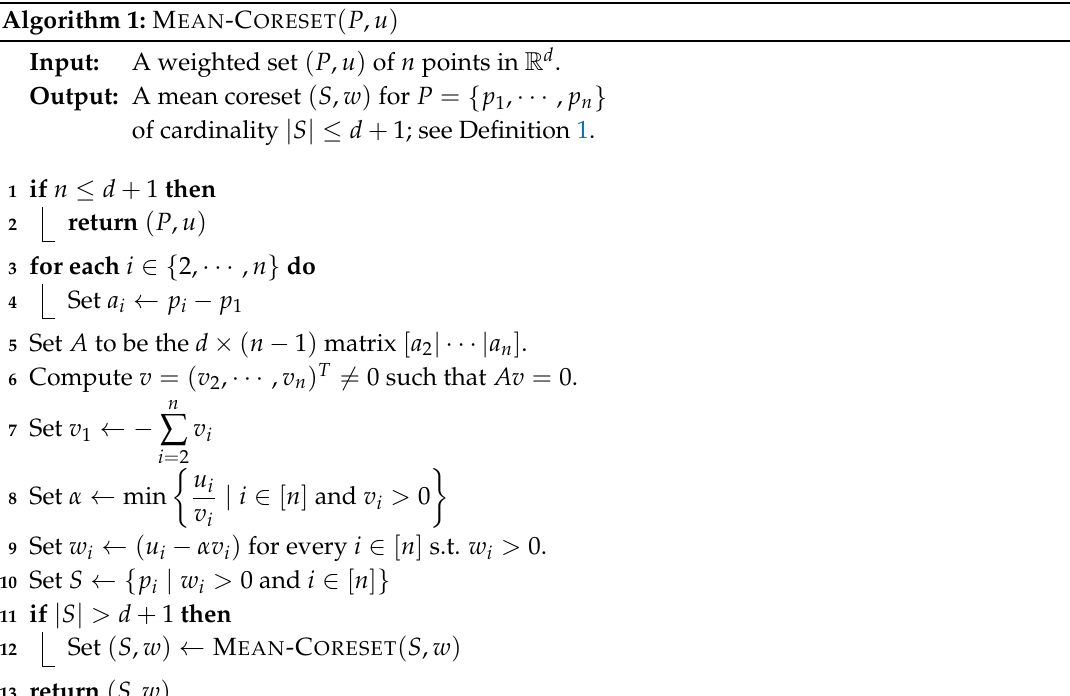
Algorithm 1: M EAN -C ORESET ( P , u